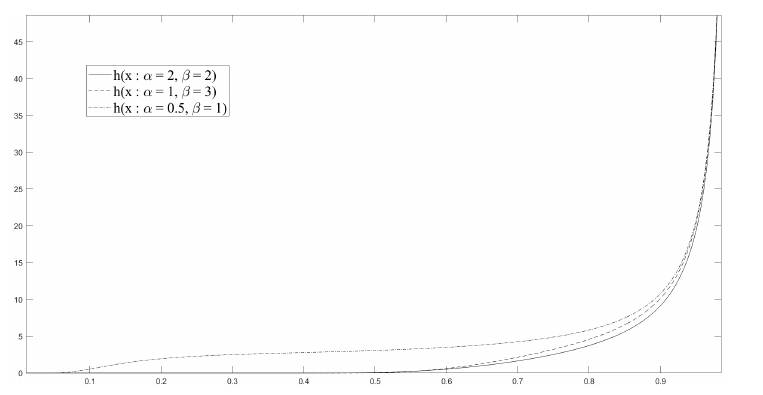
Figure 3 – Hazard rate functions of unit-Gompertz distribution for ( α = 2, β = 2 ) , ( α = 1, β = 3 ) & ( α = 0.5, β = 1 )